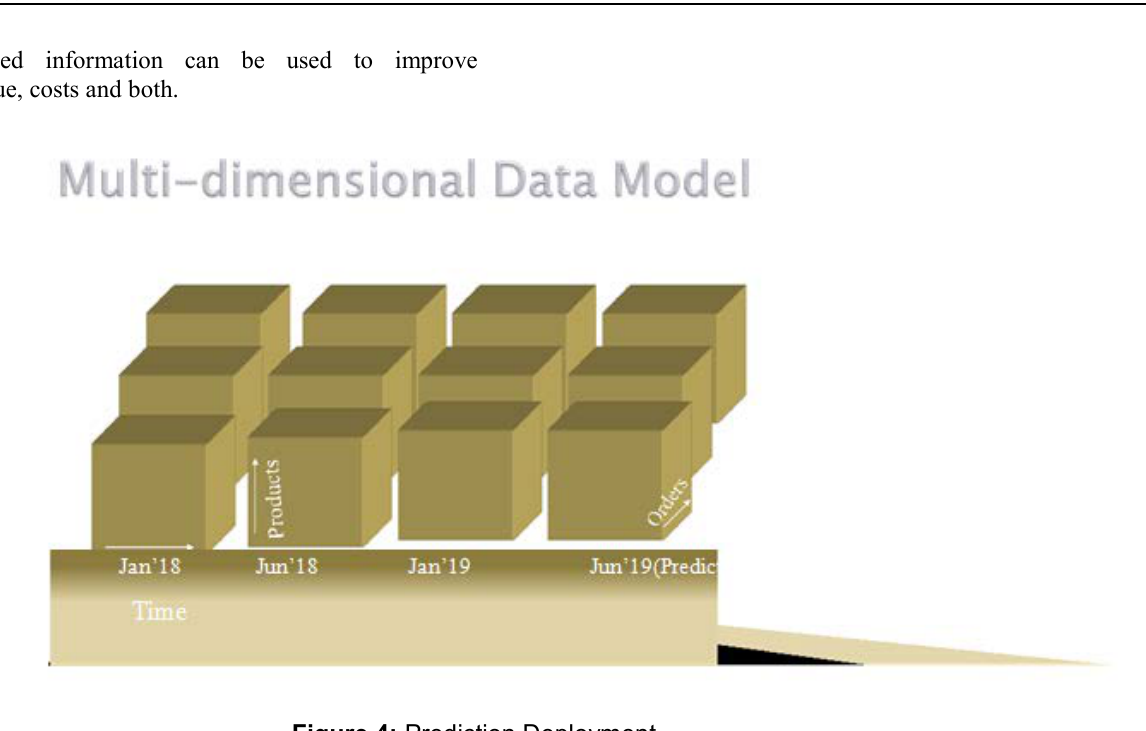
Figure 4: Prediction